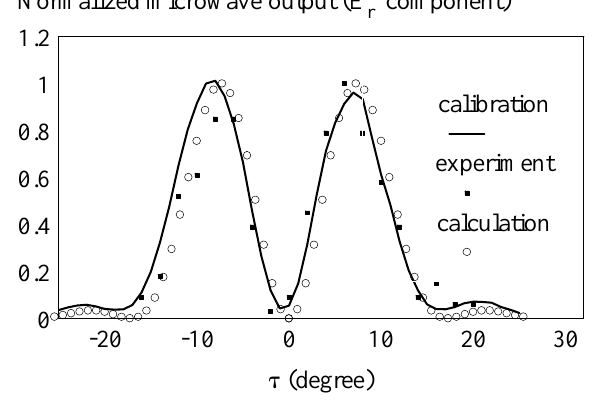
FIG. 3. Typical waveforms of the discharge voltage, the beam current, and the microwave pulse.